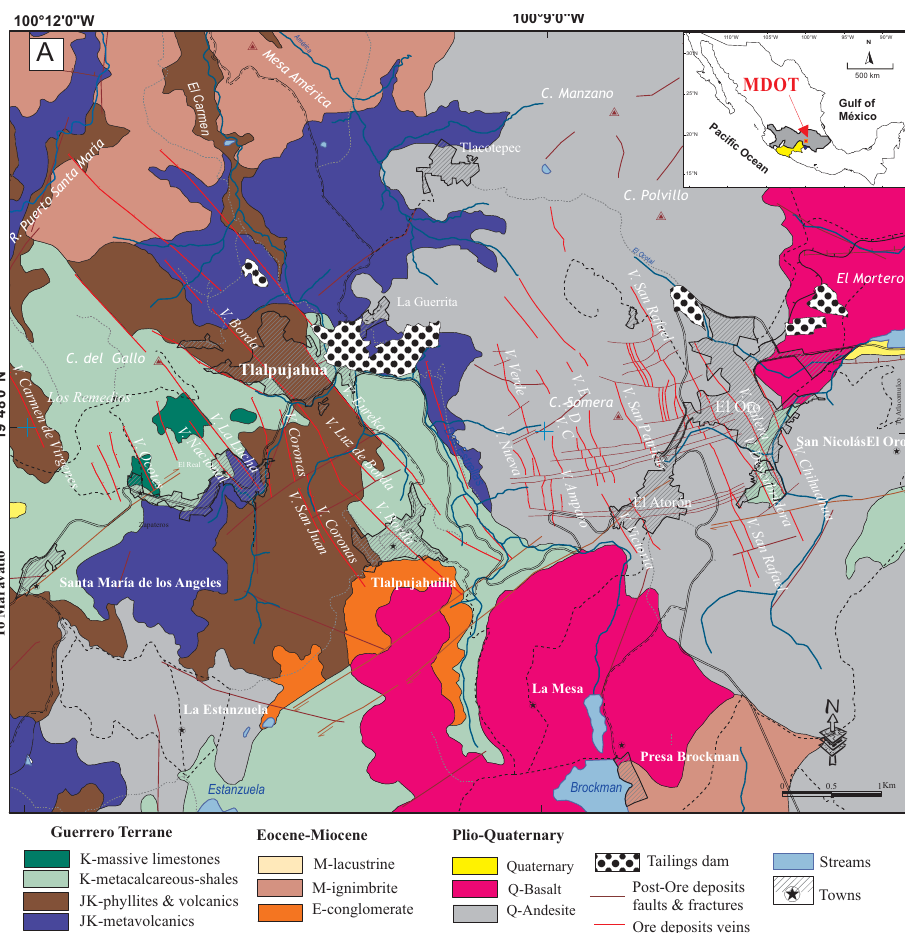
Figure 1. Location of the mining district of El Oro-Tlalpujahua (MDOT) in central Mexico (inset), (a) showing the principal rock types, ore veins, and tailings dams. Geological map of the MDOT from Corona Chávez et al.